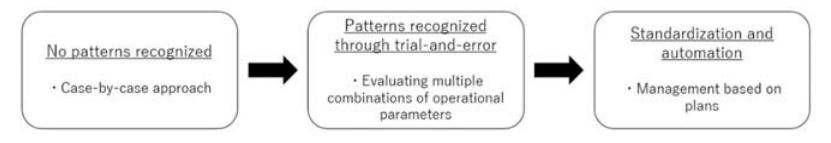
Figure 3. Acquiring knowledge on operational